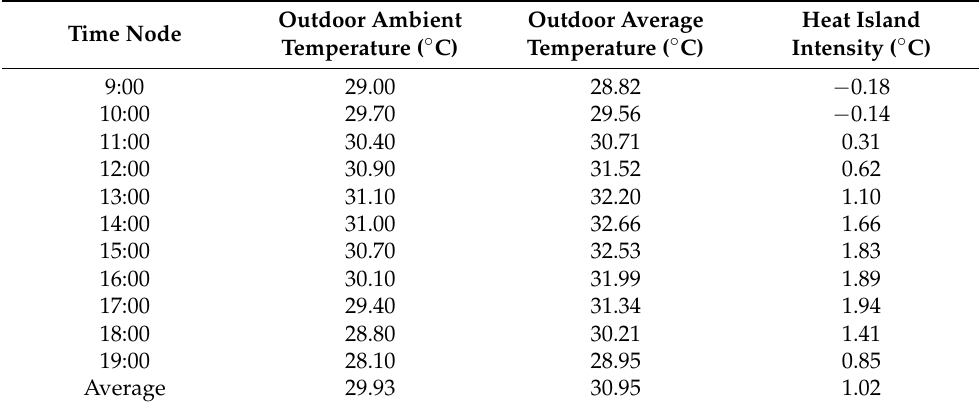
Table 7. Cell average heat island intensity data simulation based on ENVI-MET.